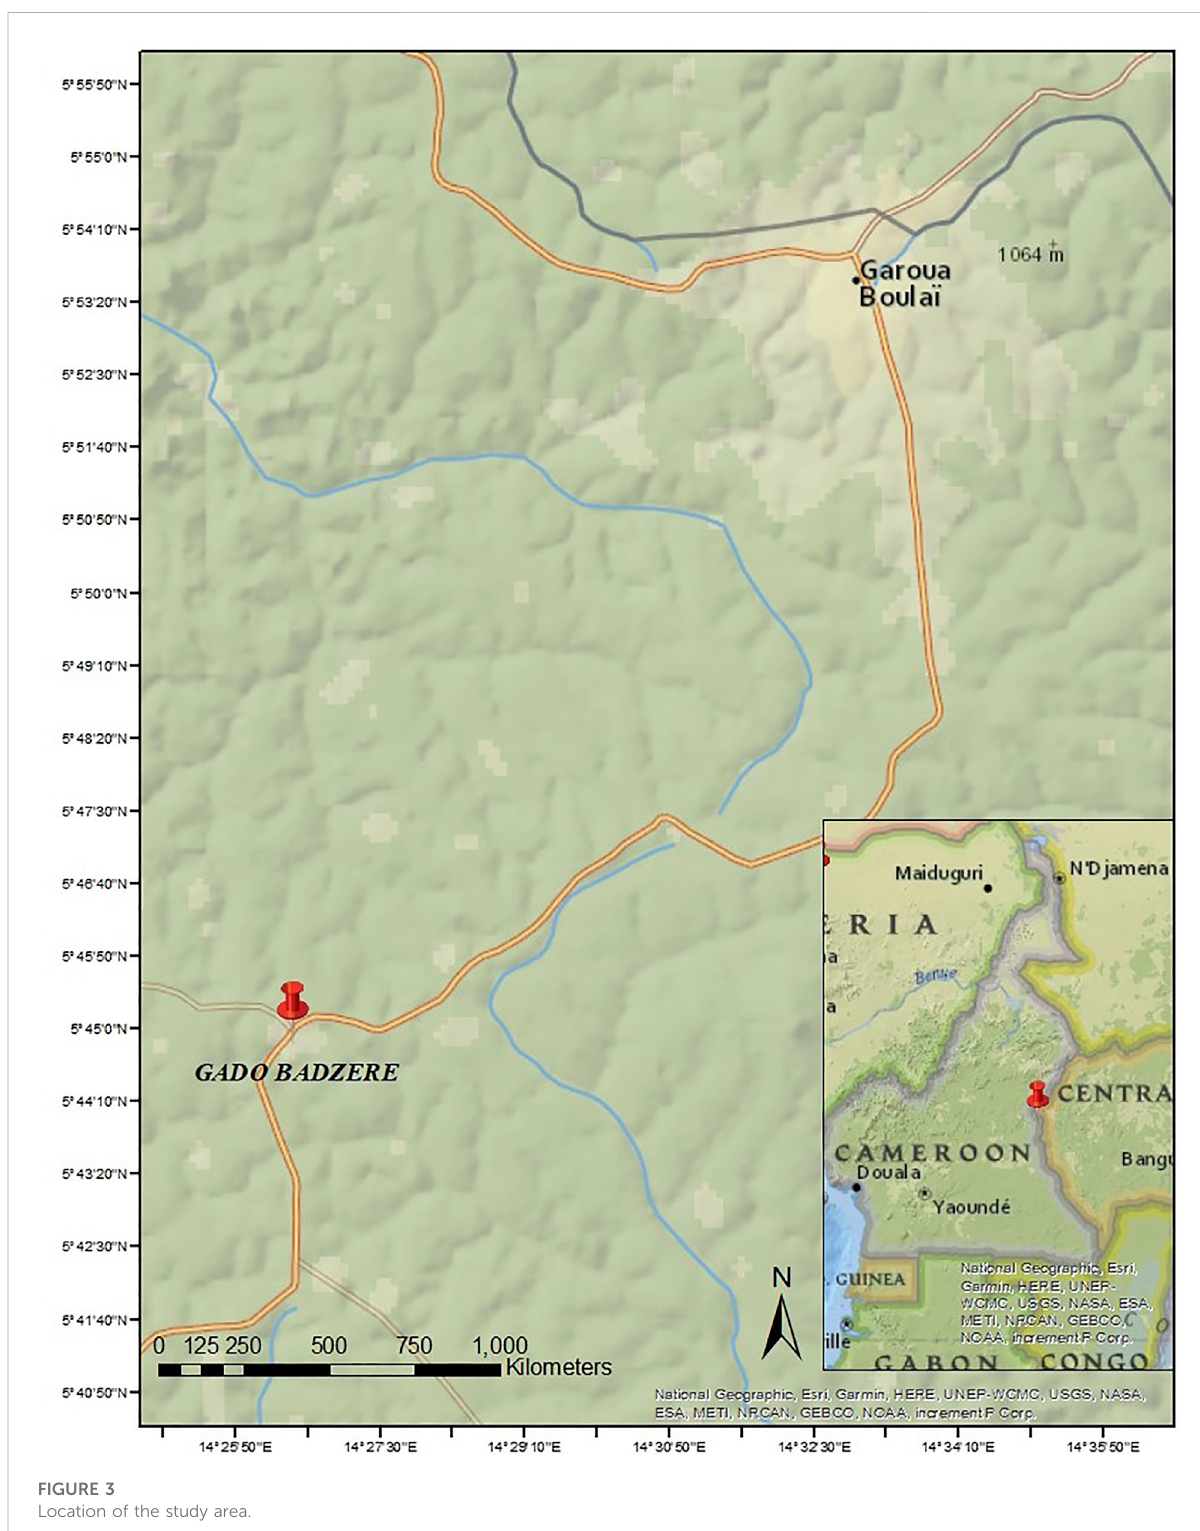
FIGURE 3 Location of the study